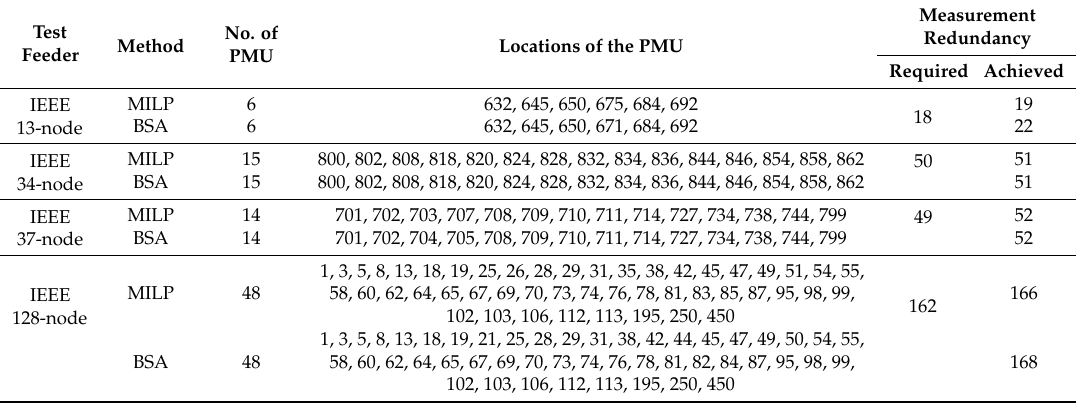
Table 7. Optimal numbers and locations of PMU for different distribution test feeders under single line outage case considering ZIB